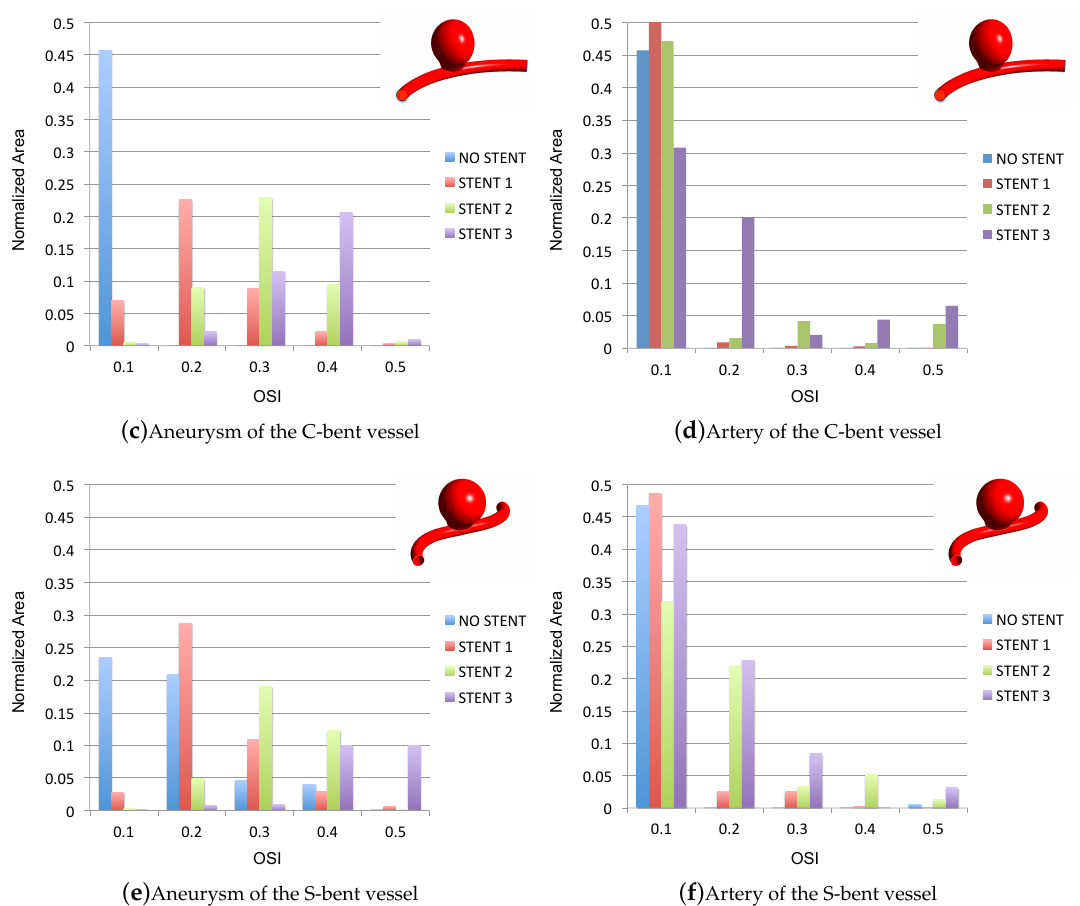
Figure 8. Histograms of the normalized area associated to the OSI of the aneurysm and of the artery (and stent) for V-bent, C-bent and S-bent vessel configurations. The depicted areas are normalized with respect to the area of whole geometry